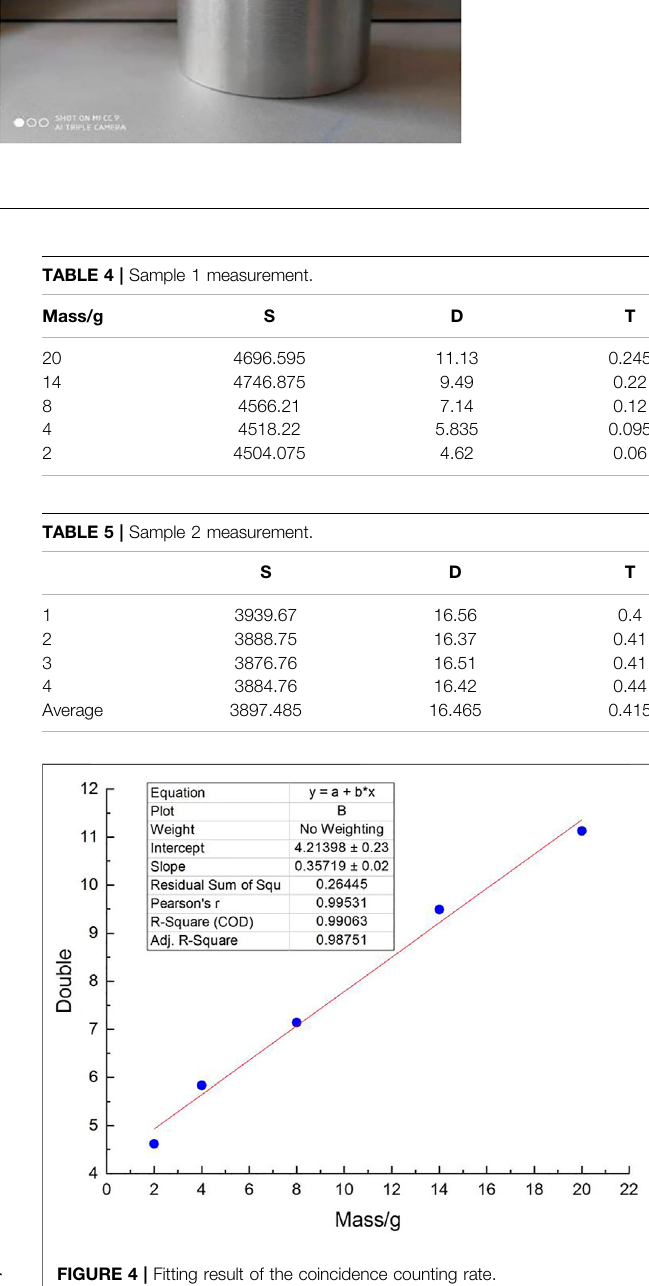
FIGURE 4 | Fitting result of the coincidence counting